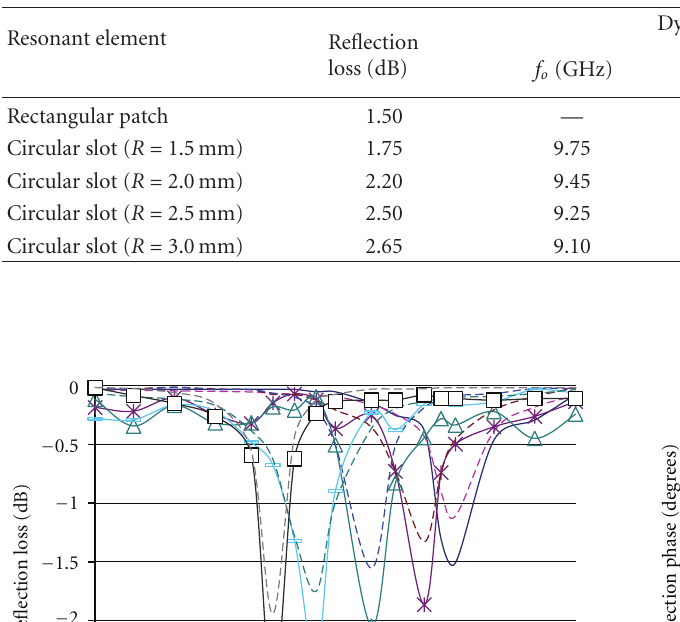
Table 1: Performance comparison for di ff erent resonant elements of reflectarray.